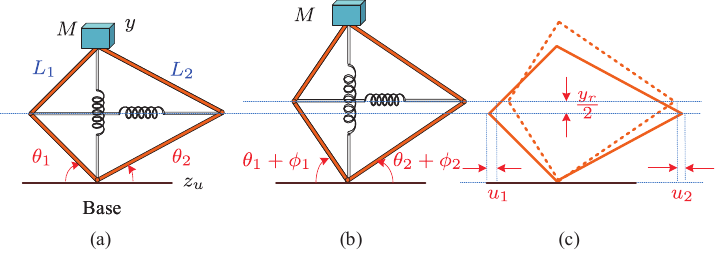
Figure 6. X-shaped structure ( a ) with the original state, ( b ) with the deformation, and ( c ) the comparison